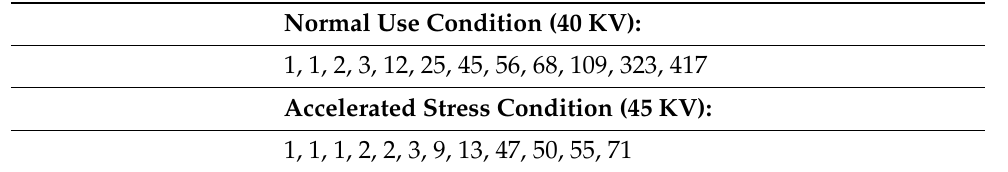
Table 8. Time to breakdown of steel specimens, complete